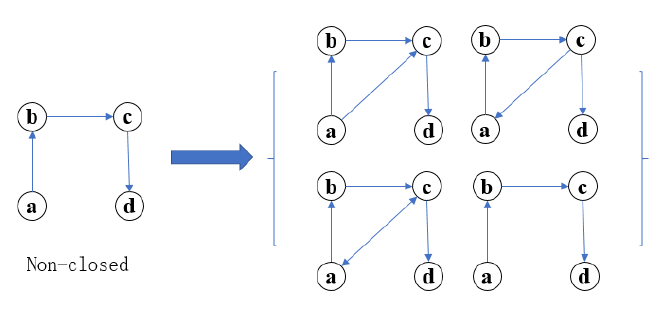
Figure 3. Closed fourth-order motif subgraphs and non-closed fourth-order motif subgraphs.